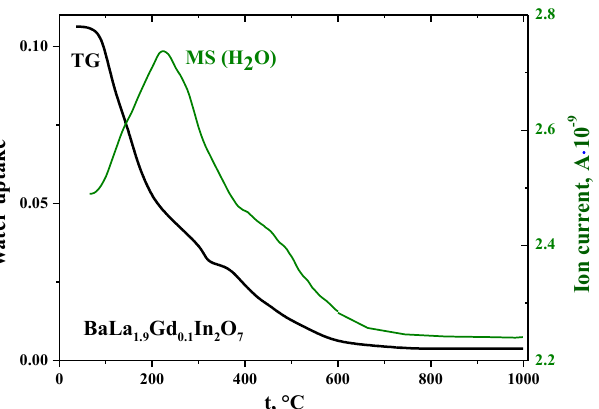
Figure 2. Thermogravimetry (TG) and mass spectrometry (MS) results for the composition BaLa 1.9 Gd 0.1 In 2 O 7 .